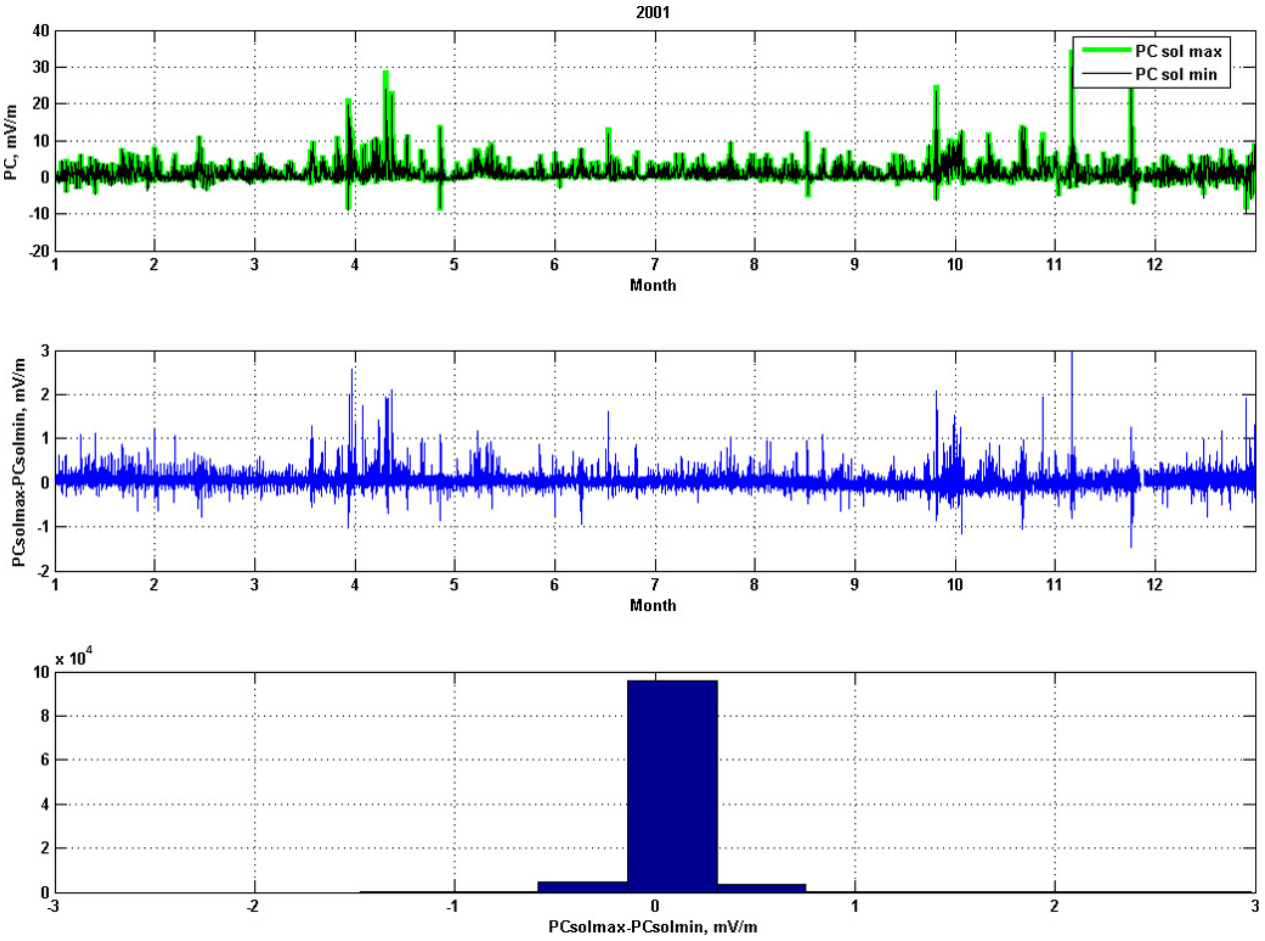
Fig. 8. Variations of indices PC solmax (thick line) and PC solmin (thin line) at Vostok throughout the year 2001 (upper panel), difference (PC solmax − PC solmin ) in a larger scale (middle panel), and distribution plots for the differences (lower